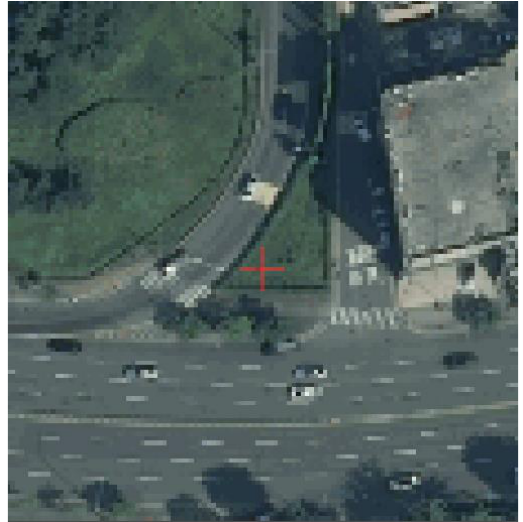
Figure 2. View of GCP chip(center of the red cross: ground coordinates of GCP).